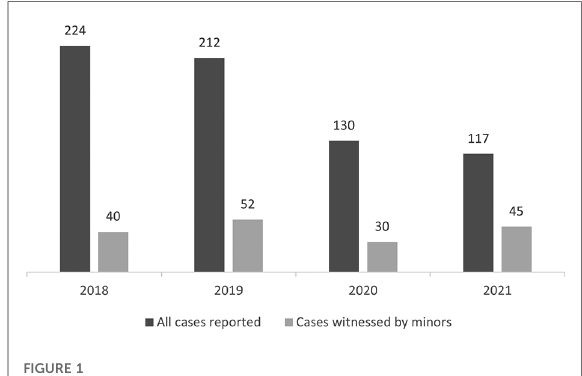
FIGURE 1 Admissions due to abuse in general and to abuse reportedly witnessed by at least a minor.